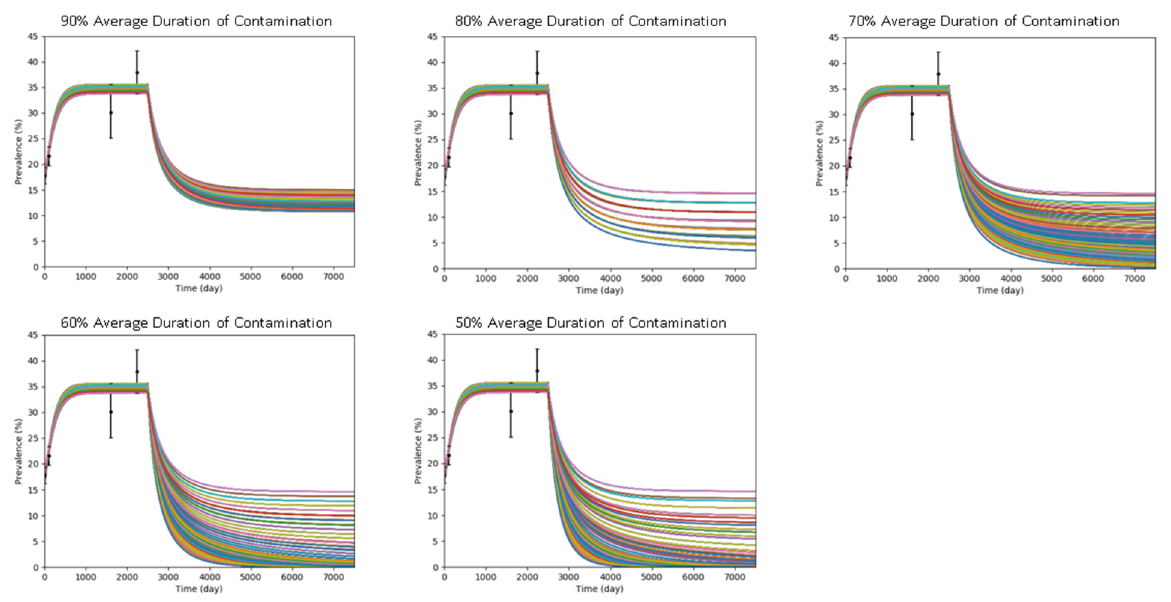
Figure 3. Plots of combined effect of hand-hygiene compliance and screening-and-isolation upon admission to MRSA colonization prevalence. Interventions were implemented on Day 2500. Table 2. Combined effect of hand-hygiene compliance and screening-and-isolation upon admission to MRSA colonization